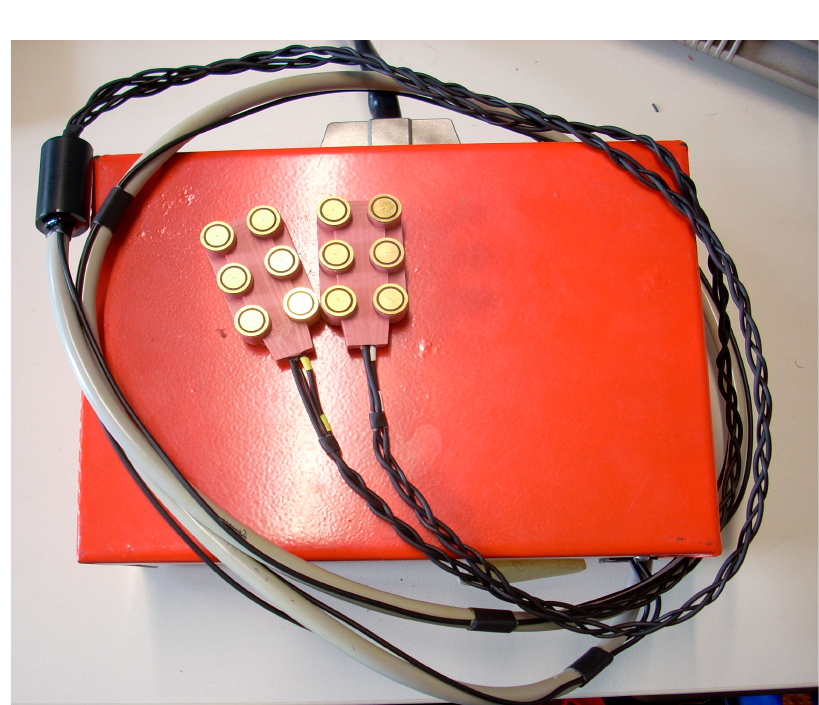
Figure 3. An example of MC ‐ EGG, used for the experiments.